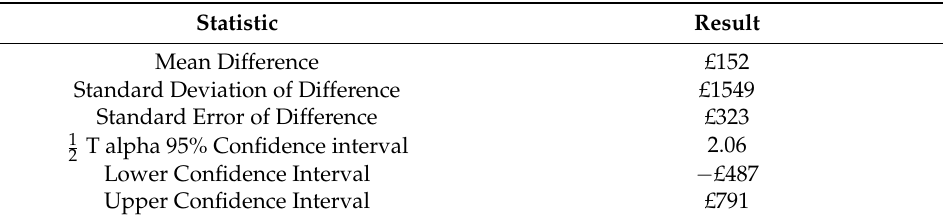
Table 7. Summary of statistical data following t